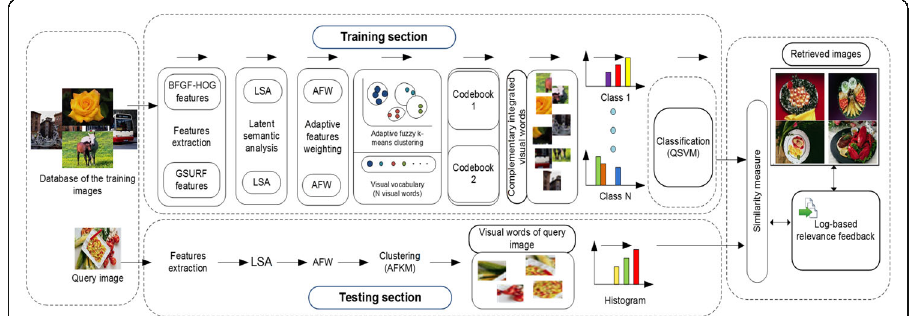
Fig. 3 Framework of the proposed adaptive complementary visual words integration based on the BoVW